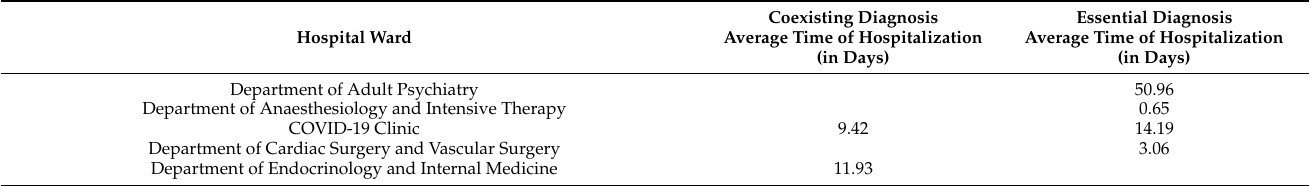
Table 5. Average time of hospitalization (in days) of specific hospital wards broken down into coexisting and essential diagnoses in relation to the diagnosis associated with